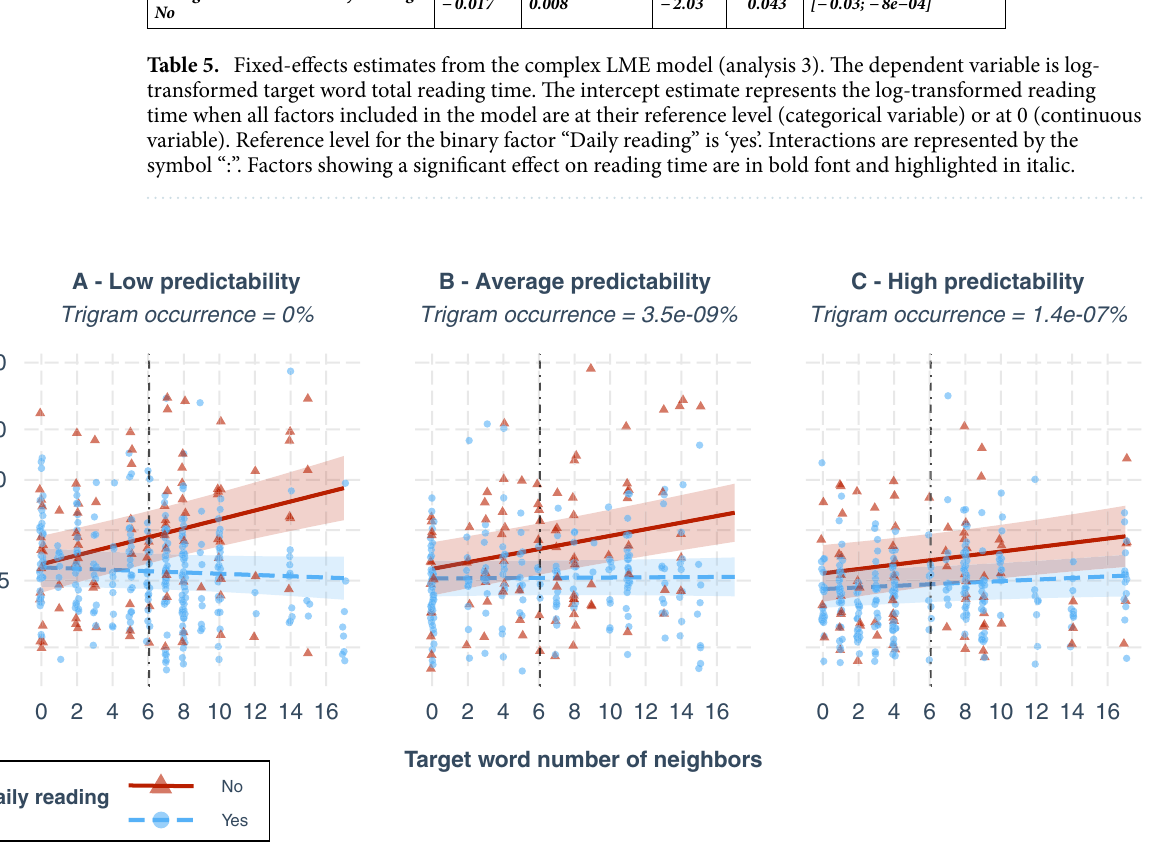
Figure 6. Effect of neighborhood size (N) on reading time, depending on word predictability and reading proficiency. Raw data points and fitted lines estimated by the LME model are grouped by reading proficiency: red for participants who quit reading on a daily basis, blue for participants still reading daily. Each subplot represents the effect of N for a different value of the trigram occurrence distribution, split into three equal-sized groups (i.e., terciles): ( A ) median of the lower tercile, ( B ) median of the middle tercile, ( C ) median of the upper tercile ( C